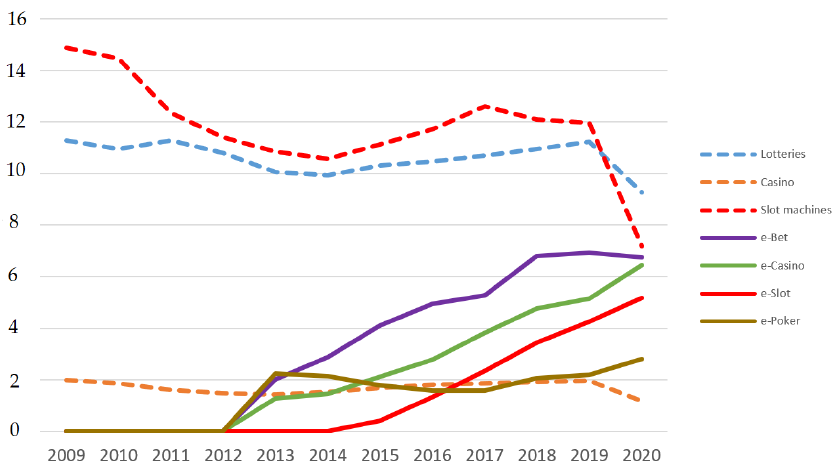
Figure 3. Spending on each type of gambling game (offline and online) (data are billions of Euros). Regarding offline gambling, spending on lotteries, casinos, and slot machines fell